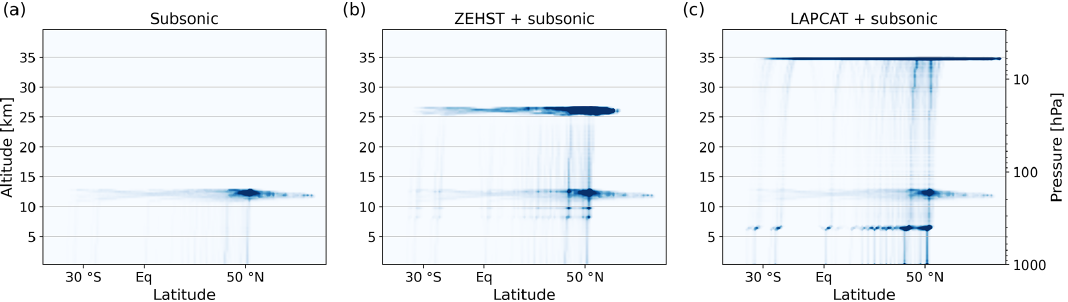
Figure 2. Zonal sum of trace gas emission location; (a) depicts the subsonic reference scenario, (b) depicts the ZEHST scenario, with a hypersonic market penetration of 9.8%, and (c) depicts the LAPCAT scenario, with a hypersonic market penetration of 26.0%. A color bar with units is not shown, since the location (altitude, latitude) is the interesting piece of information here. For annual amounts of emissions, see Table 2. The data is taken from the HIKARI project’s emission inventory. Table 2. HIKARI emission inventory. Annual emission of trace gas species H 2 O, NO x , and H 2 . The upper three rows contain amounts of trace gases emitted in the whole atmosphere, while the lower three rows contain amounts of trace gases emitted at stratospheric altitudes only (above 100hPa). Note that for ZEHST and LAPCAT, a part of the subsonic aviation is replaced by hypersonic transport; hence, the numbers depict whole air traffic scenarios.